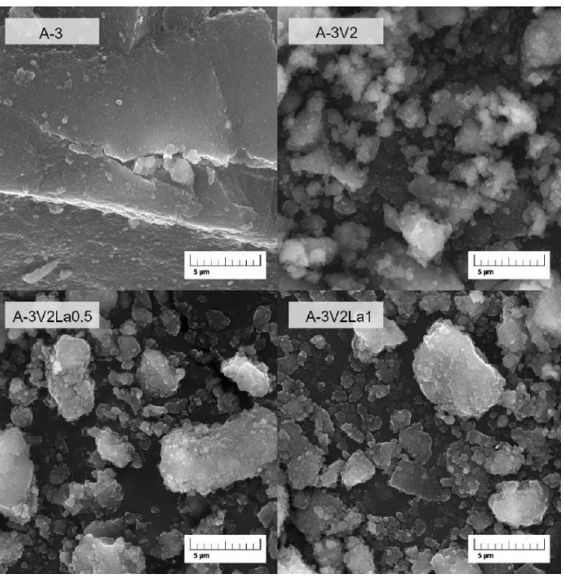
Figure 2. SEM images with 5 µm scale bar for the samples selected for catalytic testing: A-3, A-3V2, A-3V2La0.5 and A-3V2La1.